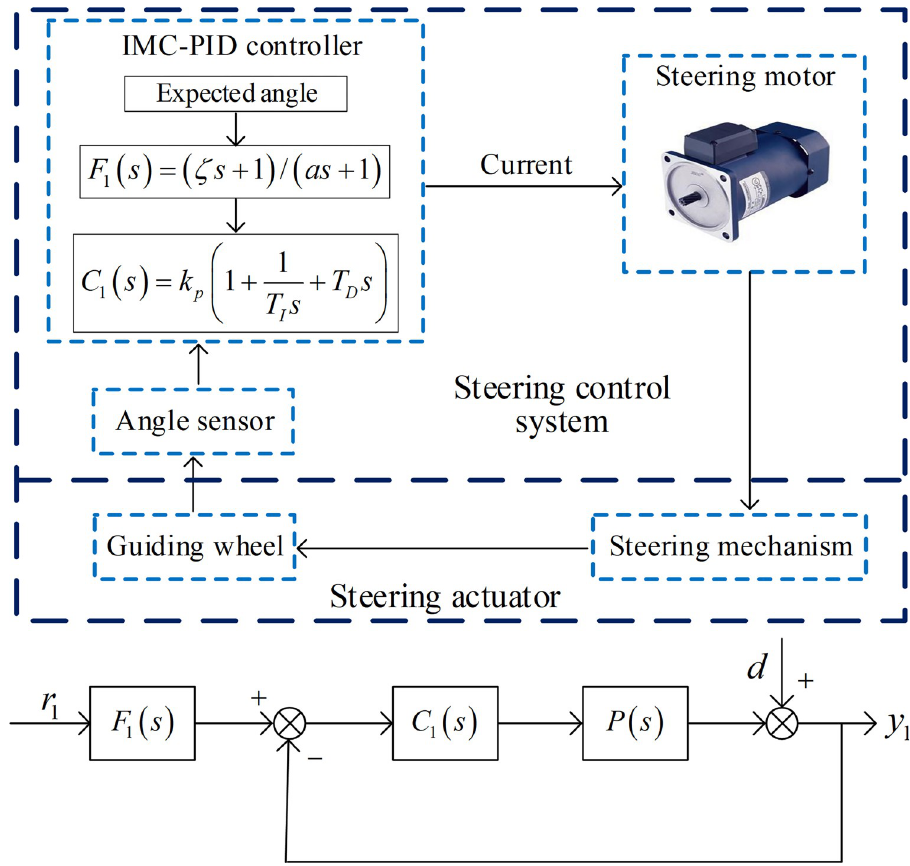
Fig 11. Structure diagram of the steering angle tracking control strategy. (a) Block diagram of steering system control, (b) System structure of steering control.